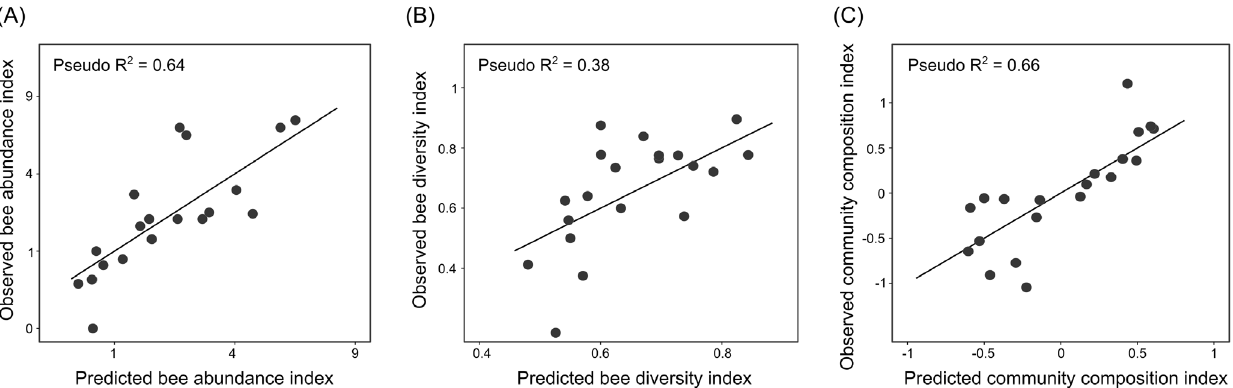
Figure 3. Observed versus predicted bee community metrics. Relationships between observed and predicted values for abundance, diversity, and community composition. Pseudo-R 2 is derived from regressing observed values versus model-averaged predictions. The graph for abundance displays only 19 points because two data points overlap.